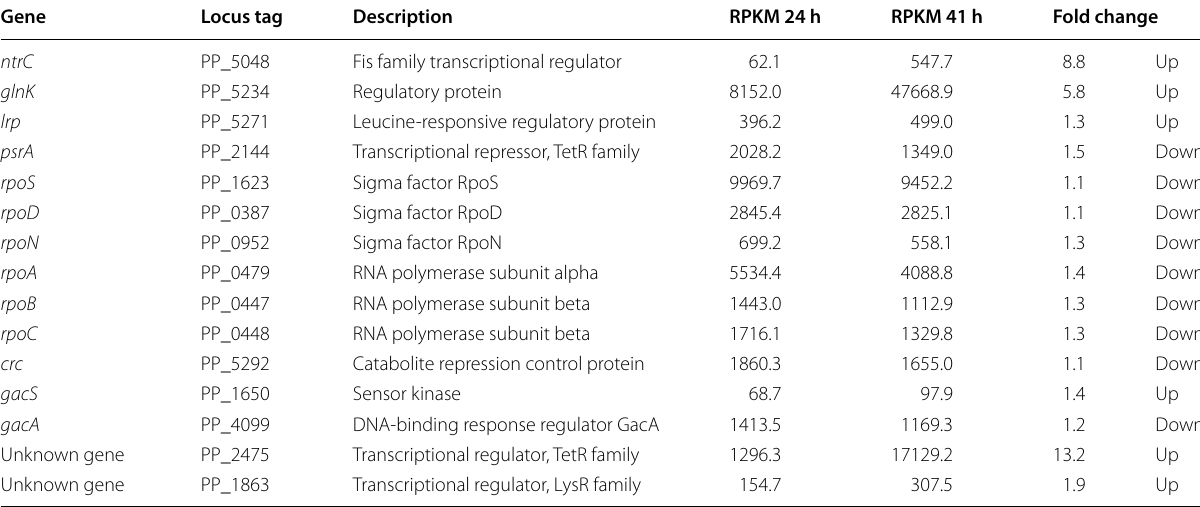
Table 4 Differences in regulatory genes transcription between exponential growth (24 h) and stationary phase (41 h) expressed in